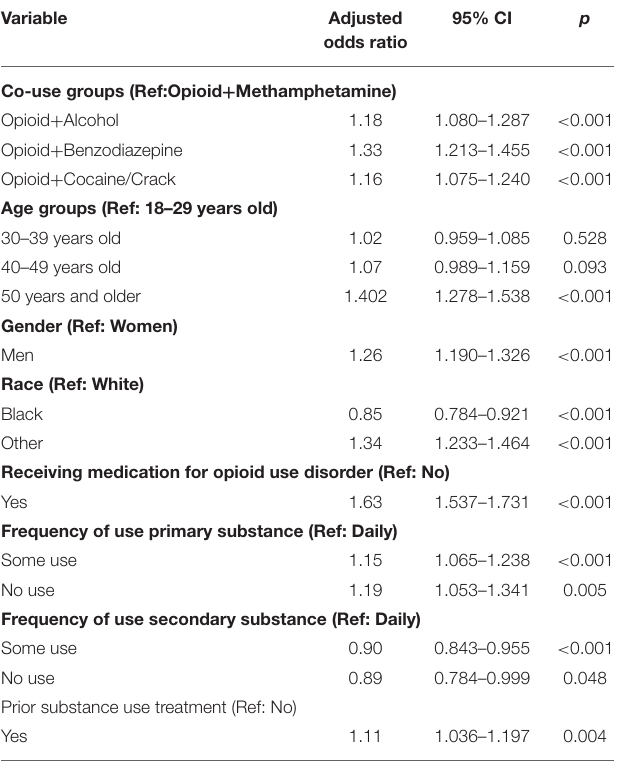
TABLE 3 | Logistic regression model predicting treatment completion by co-use groups and covariates.